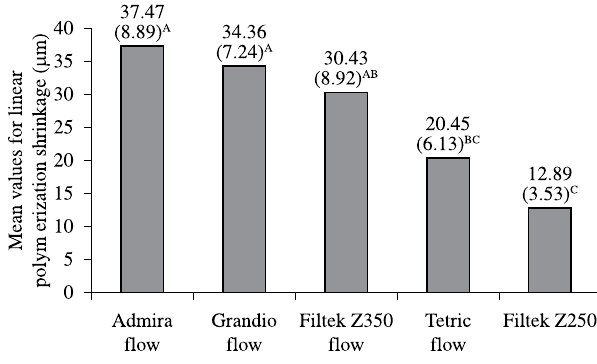
Figure 1. Mean values of LPS (µm) and standard deviations ( ) of the materials studied. Different superscript letters indicates that the materials are statistically different at 5% using the Tukey test.